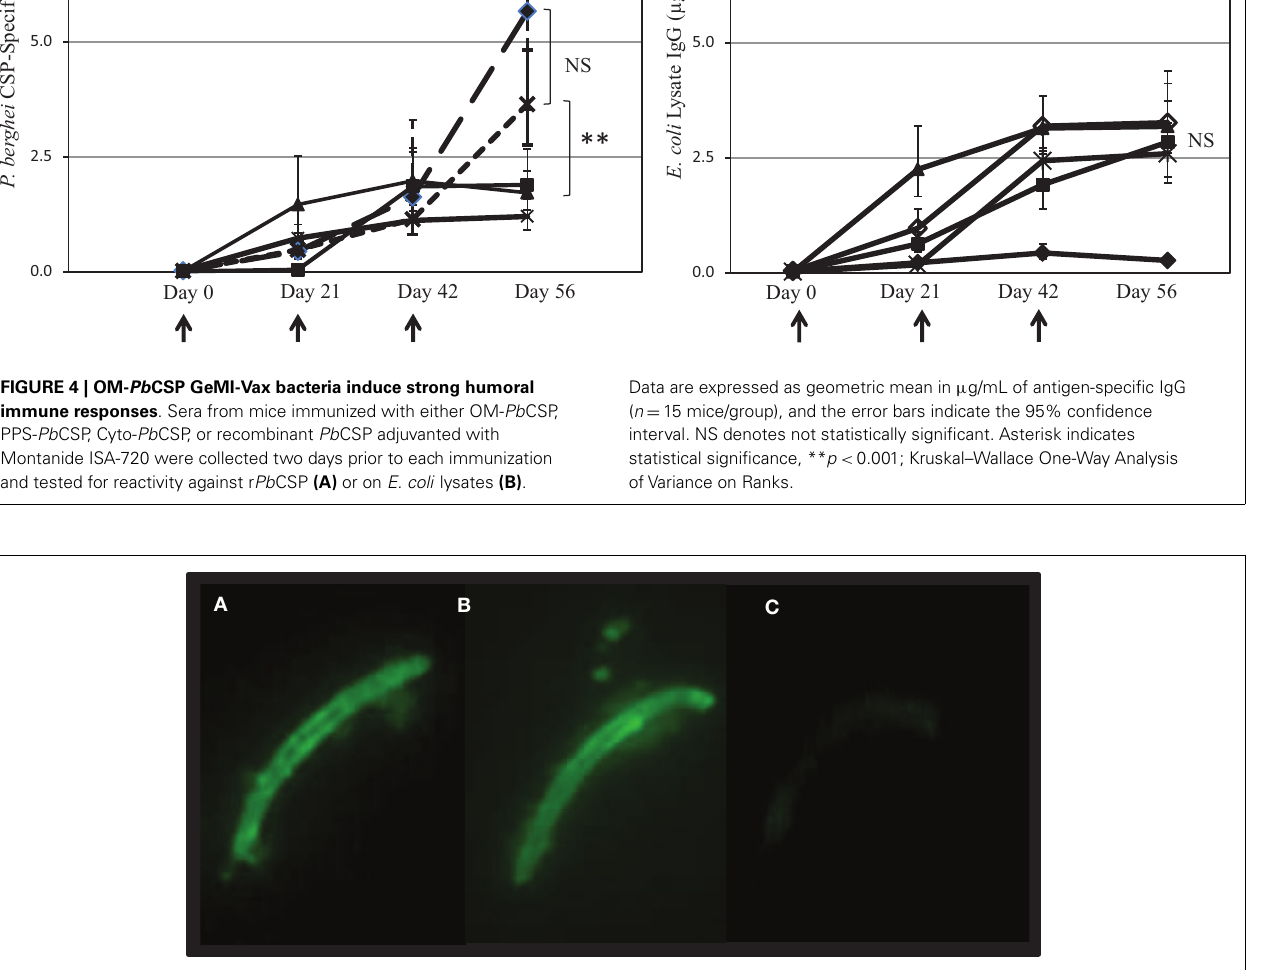
FIGURE 5 | OM- Pb CSP-GeMI-Vax (A) and Pb CSP/ISA-720 (B) induce antibodies that react with P. berghei sporozoites by indirect immunofluorescence .The reactivity was specific as sera from mice